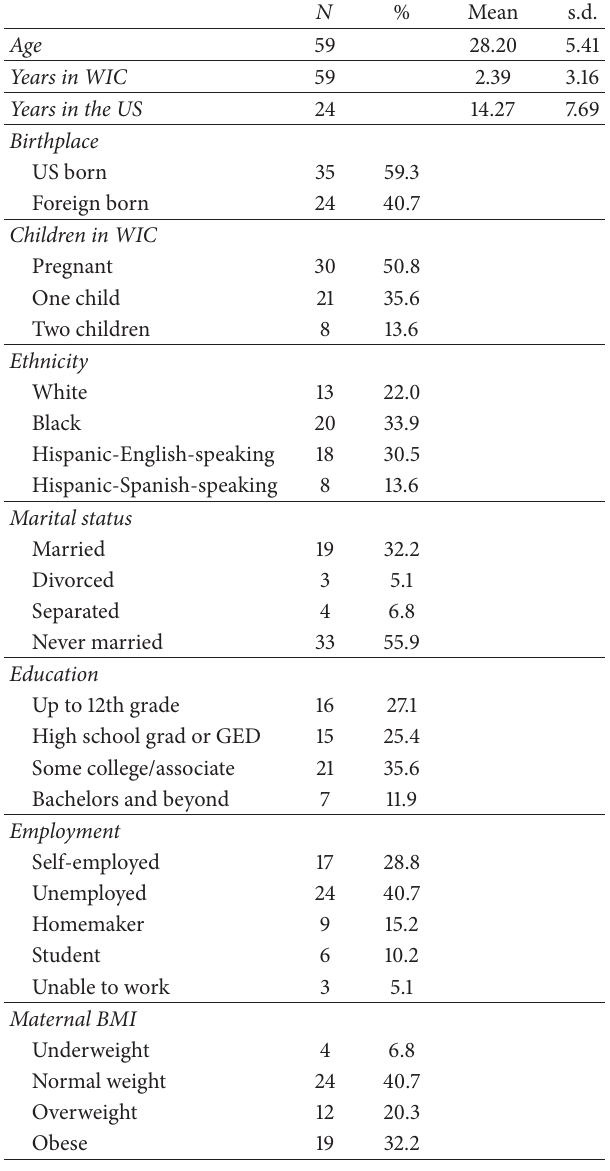
Table 1: Description of the sample ( 𝑁 = 59